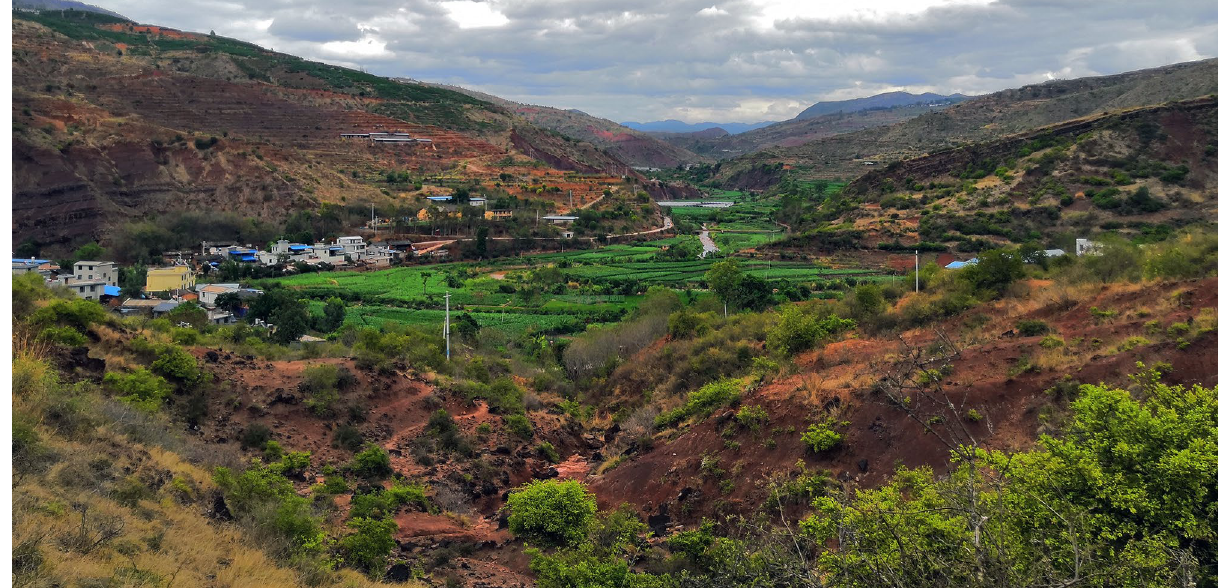
Figure 2. Field photograph taken near Irisosaurus yimenensis gen. et sp. nov. locality, showing the village of Zhanmatian on the left and the Early Jurassic reddish argillaceous siltstones surrounding it.